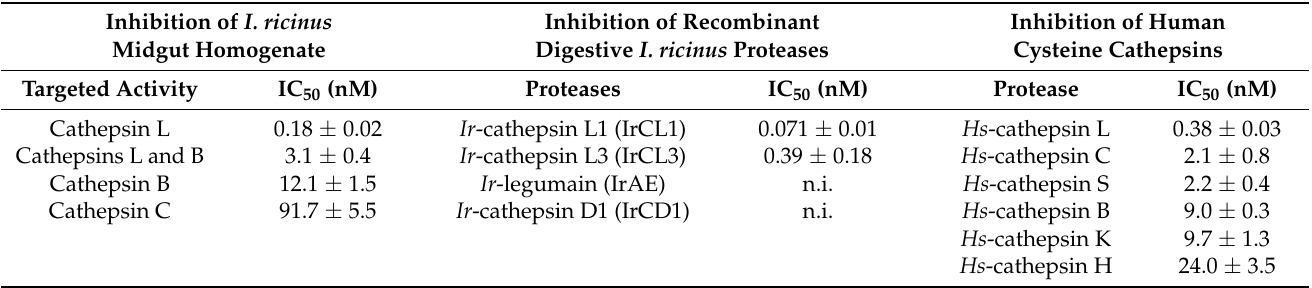
Table 1. Inhibitory effect of mialostatin on the activity of tick and human proteases. The inhibitory potency of mialostatin was determined against: (i) native cysteine cathepsins present in I. ricinus gut tissue extract using protease-specific assays (left panel); (ii) selected digestive proteases of I. ricinus prepared as recombinant proteins (middle panel); and (iii) a representative set of human cysteine cathepsins (right panel). The IC 50 values (mean values ± SE) were measured by kinetic activity assays using specific fluorogenic peptide substrates (for details, see